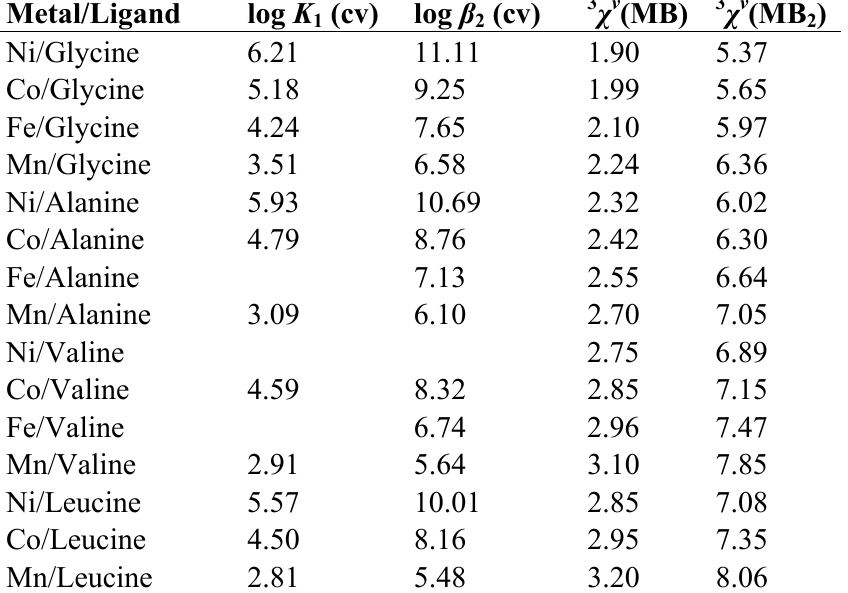
Table 3. Theoretical (cross validated) stability constants for metal(II) chelates with α - amino acids, and their 3 χ v indices.